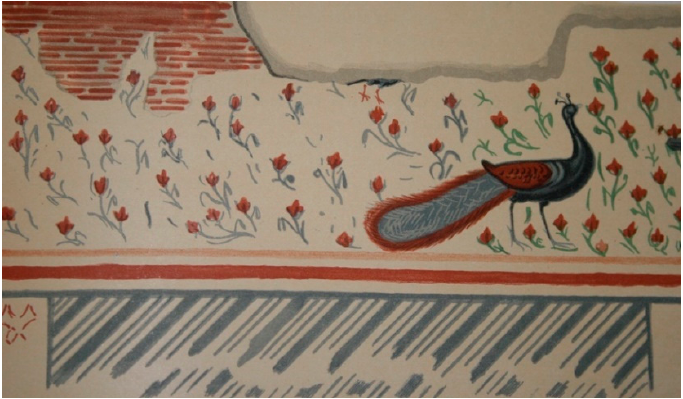
Figure 11. Sardis, “Painted Tomb” (Appendix A.2 T2), painting of north wall. © Archaeological Exploration of Sardis/President and fellows of Harvard College.